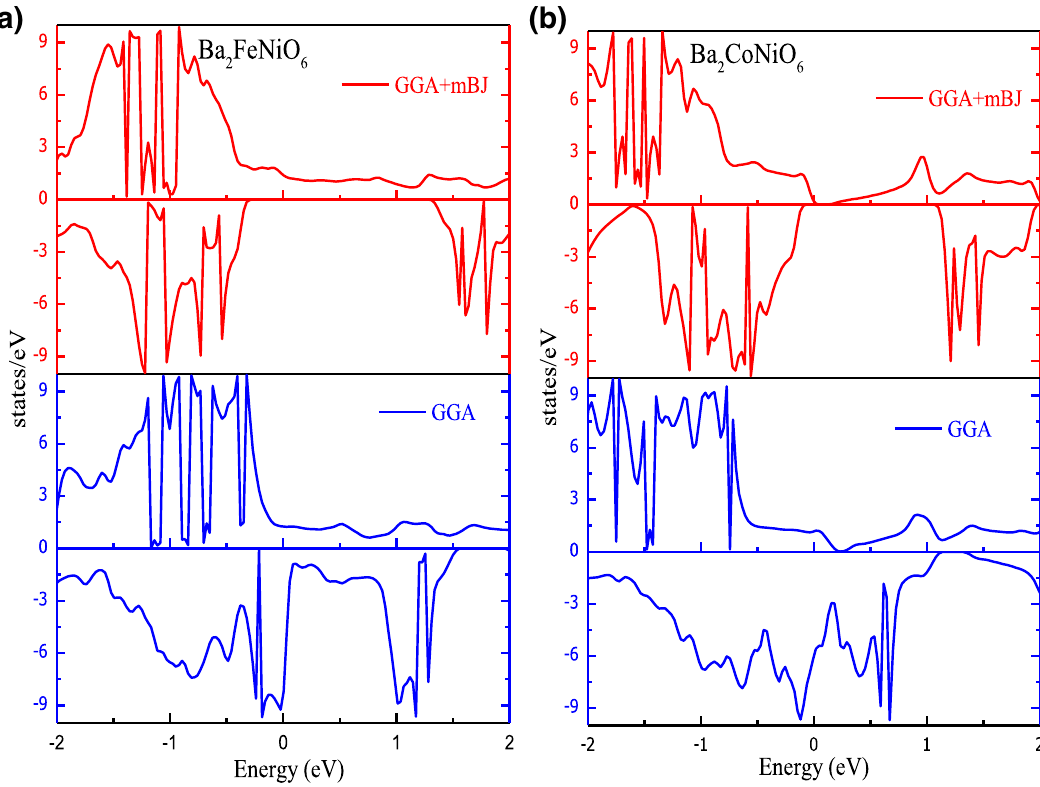
Figure 3. Density of states obtained by GGA and GGA + mBJ approximation ( a ) Ba 2 FeNiO 6 ; ( b ) Ba 2 CoNiO 6 . High DOS peaks correspond to plethora of degenerate energy states while zero DOS symbolizes bandgap/